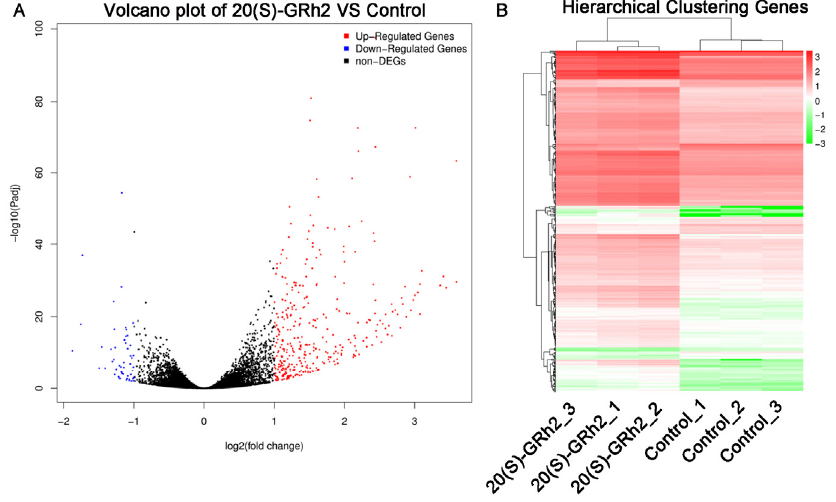
Figure 2. Identification of DEGs in 20(S)-GRh2-treated HeLa cells. ( A ) Volcano plots of DEGs are displayed using |log 2(Fold Change)| > 1 and adjusted p -value < 0.05. Red and blue dots mark upregulated genes and downregulated genes, respectively. ( B ) Cluster heatmap of DEGs with |log 2(Fold Change)| > 1 and adjusted p -value < 0.05. Red, upregulated DEGs; green, downregulated DEGs; DEGs, differentially expressed genes; 20(S)-GRh2, 20(S)-ginsenoside Rh2.